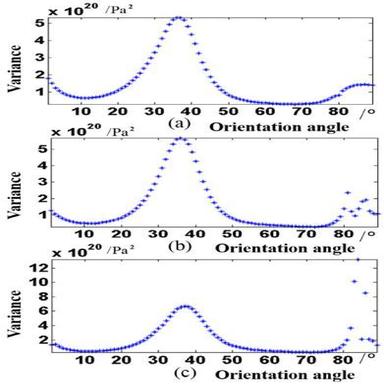
Variance of different orientation angles for (a) 691 N, (b) 818 N, and (c) 947 N with an angle step of 1∘